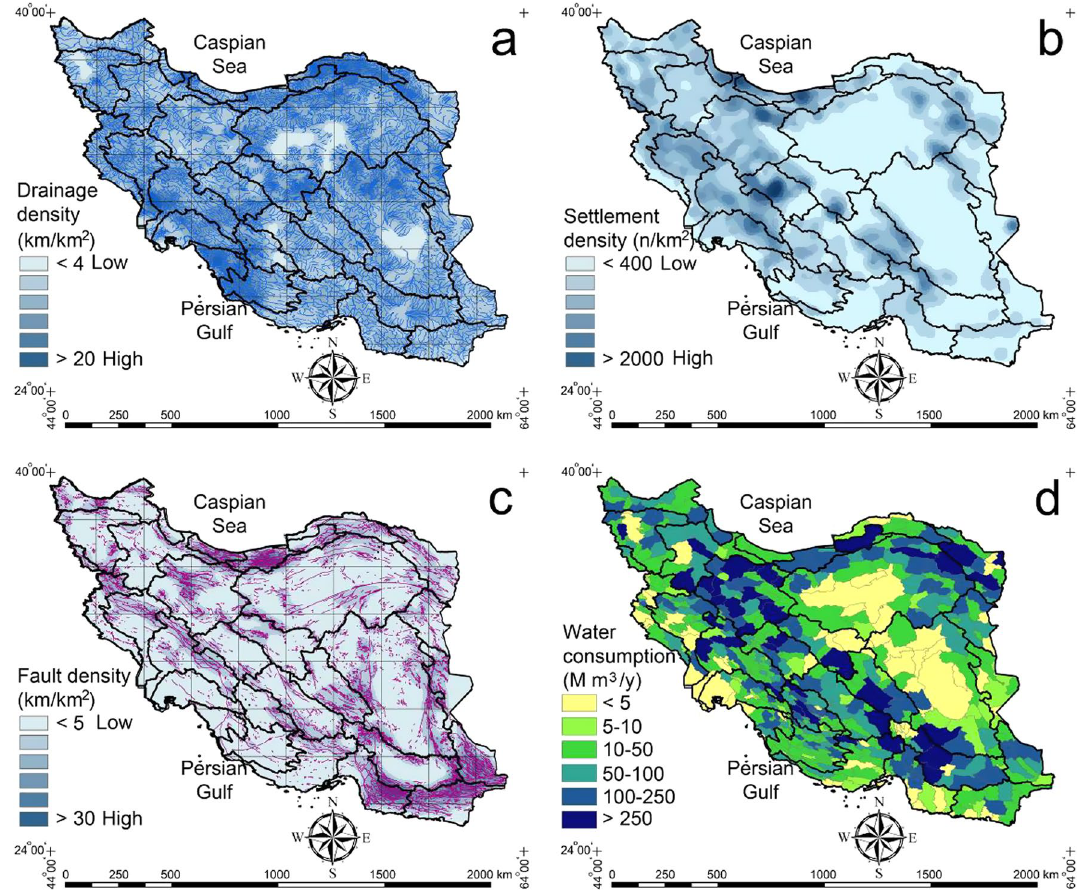
Fig. 4 Input environmental variables to efficiency assessment of the construction of the Qanat water system including a . drainage density, b . set- tlement density, c . fault density, and d . annual groundwater consumption